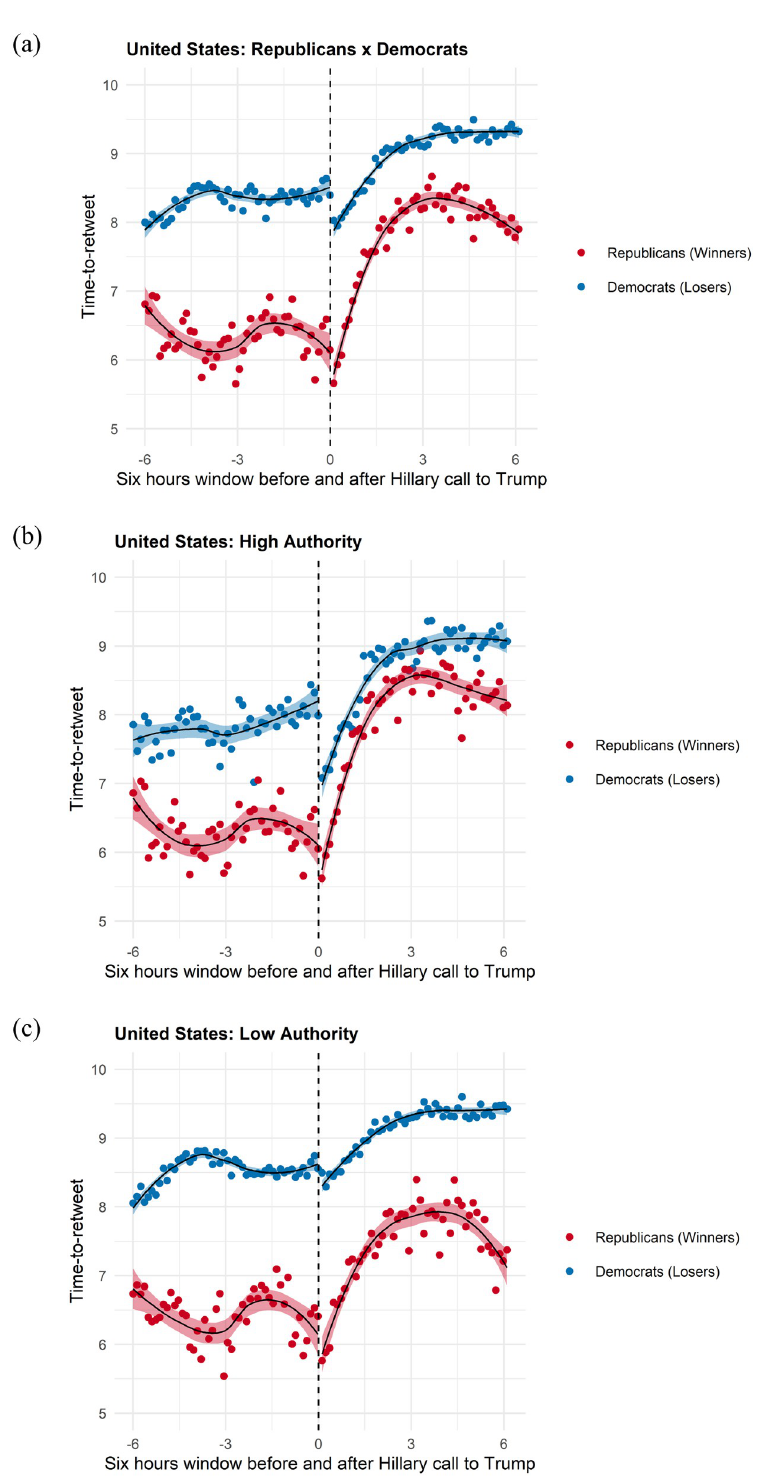
Fig 5. Time-to-Retweet in the US Election. (a) Winners vs Losers, (b) High Authority Users, (c) Low Authority Users.